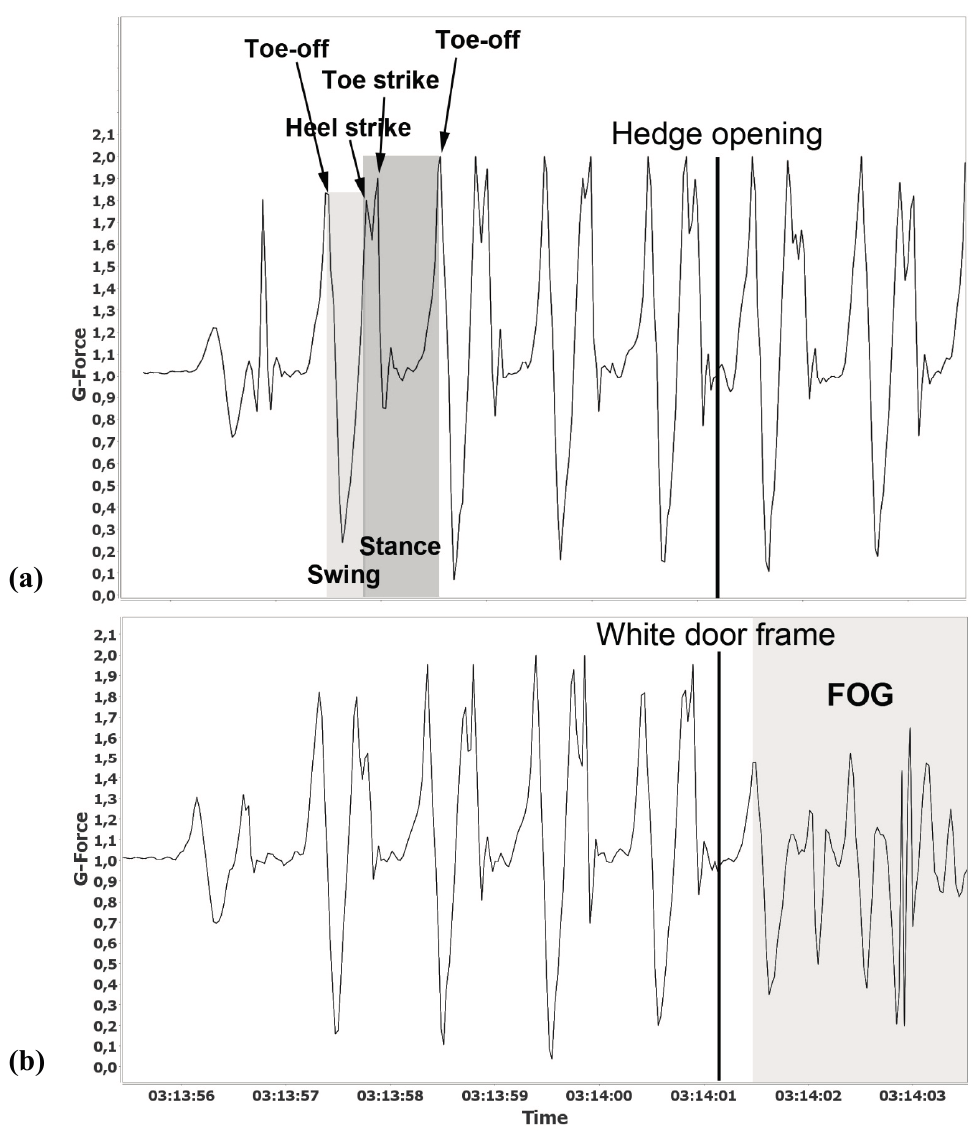
Figure 2. Accelerometer measurements. Example of patterns when passing through the hedge opening ( a ) without the white doorframe and ( b ) with the white